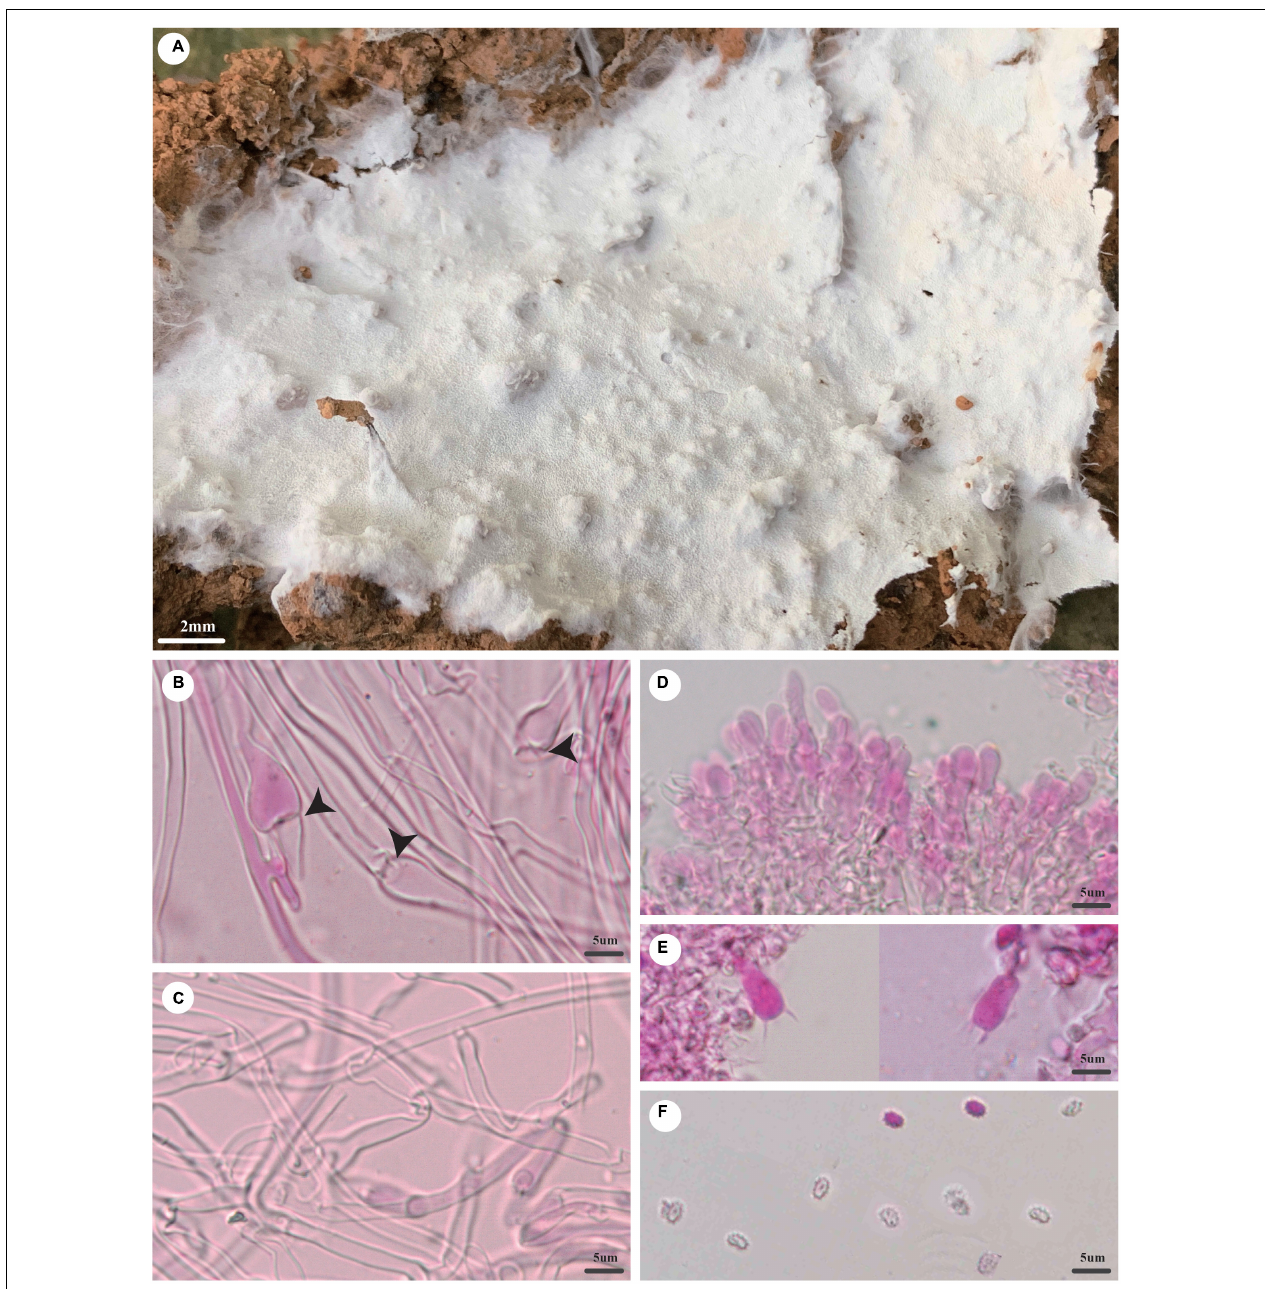
FIGURE 6 | Trechispora fragilis (holotype, Dai 20535). (A) A basidioma, (B) hyphae with ampullate septa from subiculum (black arrows), (C) hyphae from trama, (D) hymenium with basidioles, (E) basidia, and (F) basidiospores. Photo by Ya-Ping Lian and Zhan-Bo Liu. IKI − , CB − are unchanged in KOH; rhomboidal calcium oxalate crystals are